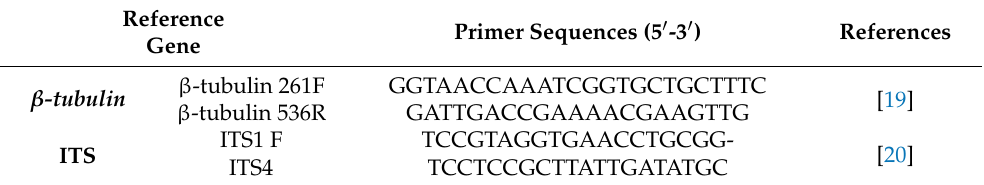
Table 1. List of primers used in the